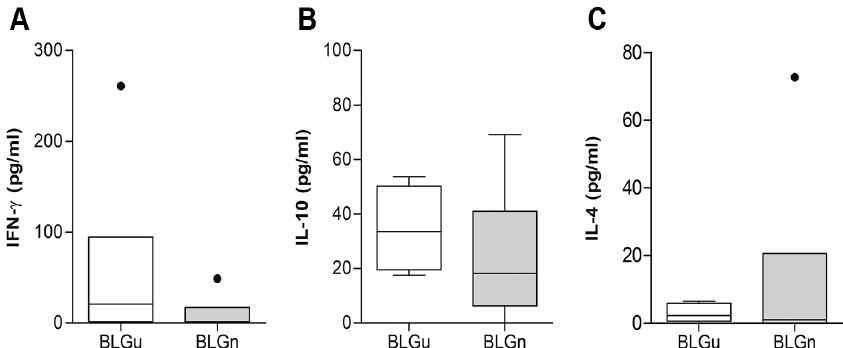
Figure 6. Re-stimulation of spleen cells with BLGu does not indicate an influence of treatment on cytokine production in allergic mice. Isolated spleen cells of BLGu-allergic mice fed with BLGu or BLGn were stimulated with BLGu, and supernatants were screened for the presence of cytokines. No significant di ff erences between BLG preparations were detected after baseline subtraction for ( A ) IFN- γ (Mann–Whitney-U-test), ( B ) IL-10 (unpaired t -test), ( C ) or IL-4 (unpaired t -test with Welch correction). BLG, beta-lactoglobulin; BLGn, nitrated BLG; BLGu, untreated BLG.